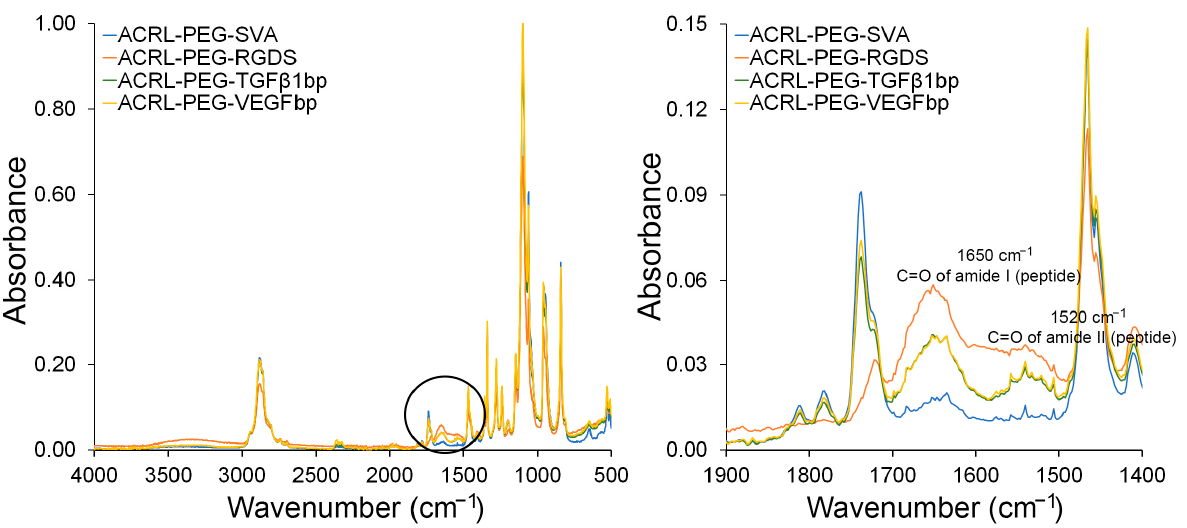
Figure 2. ATR-FTIR spectra of ACRL-PEG-SVA (blue), ACRL-PEG-RGDS (orange), ACRL-PEG-TGF β 1bp (green), and ACRL-PEG-VEGFbp (yellow). ATR-FTIR results confirmed the conjugation of the peptide binding sequences to ACRL-PEG. Table 1. Characteristic absorption IR vibration bands for PEG-acrylate and peptide